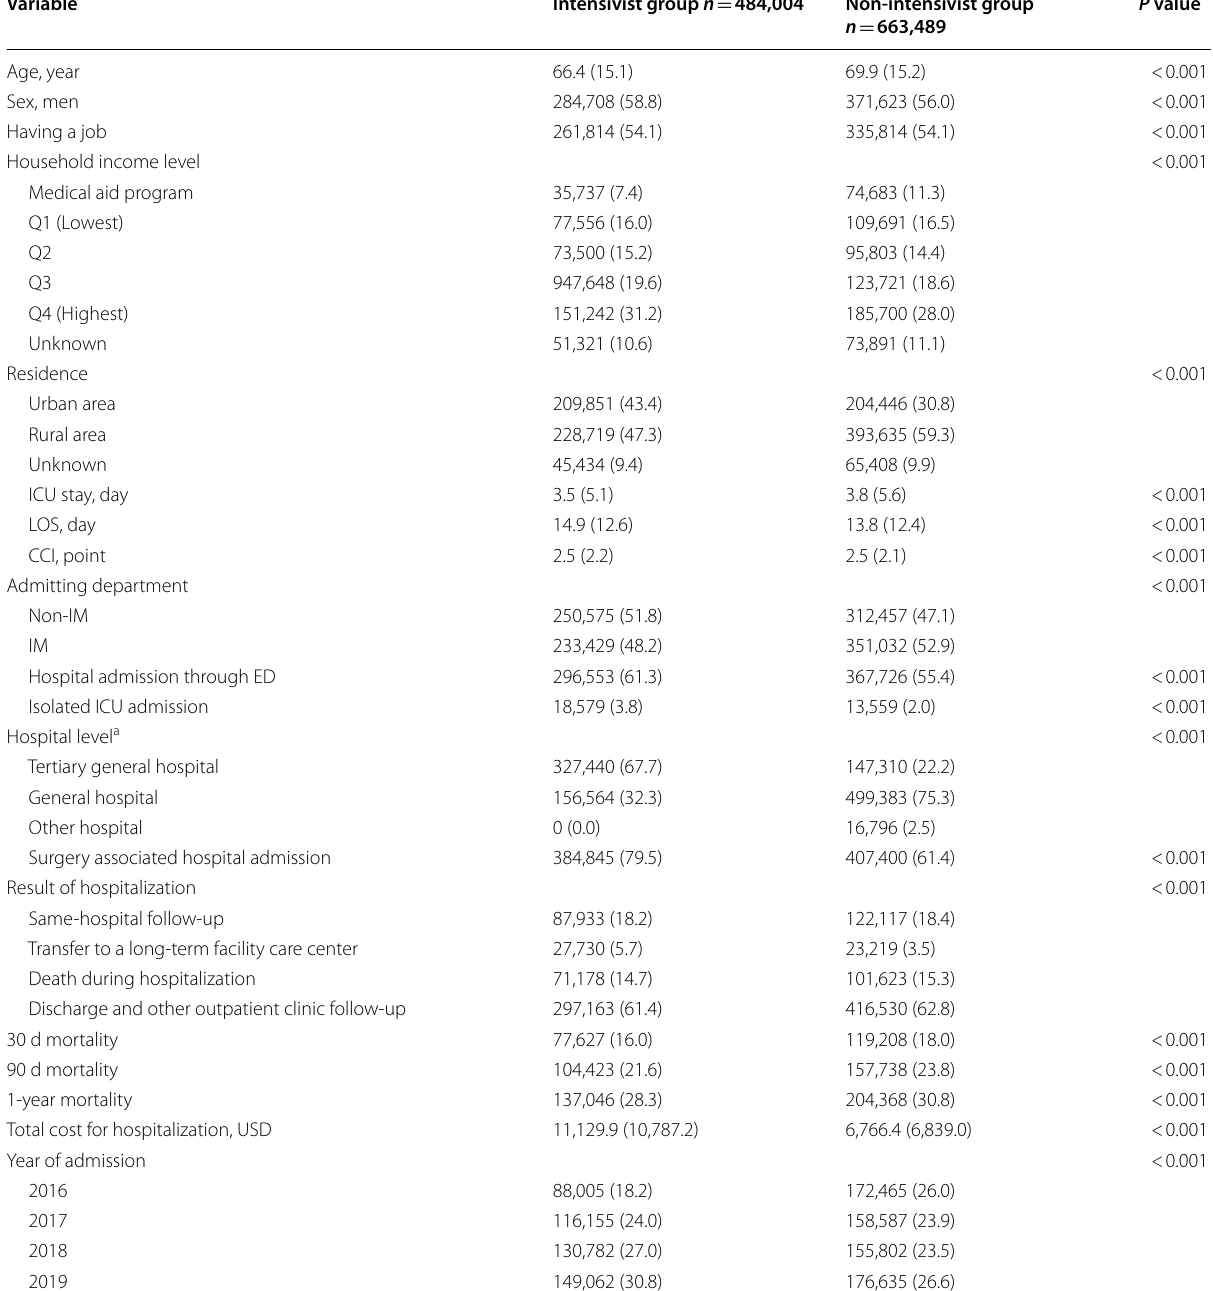
Table 1 Comparison of clinicopathological characteristics between the intensivist and non‑intensivist